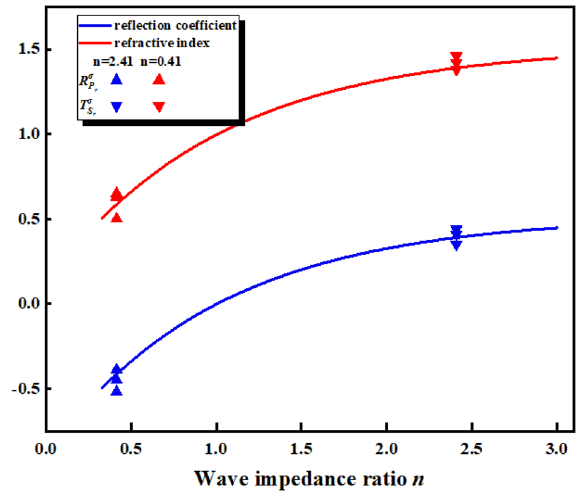
Figure 15. Reflection and refraction stress coefficients when the incident angle is 90°.